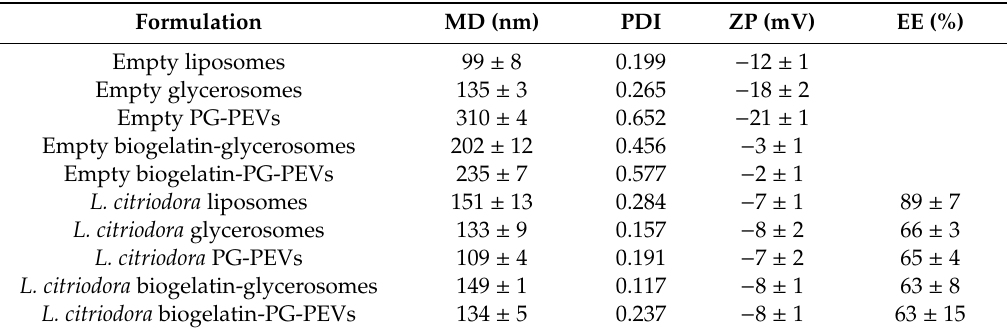
Table 3. Characterization of the vesicles including mean diameter (MD), polydispersity index (PDI), zeta potential (ZP) and entrapment e ffi ciency (EE). Mean values ± standard deviations were obtained from at least 6